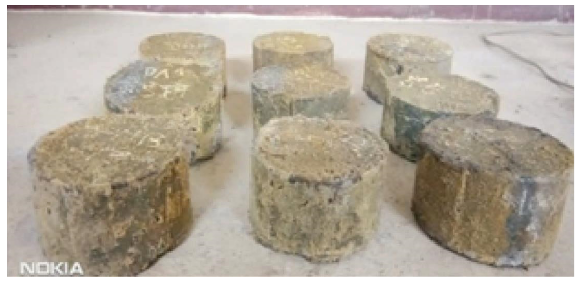
Figure 5: Specimens after exposed to acid and